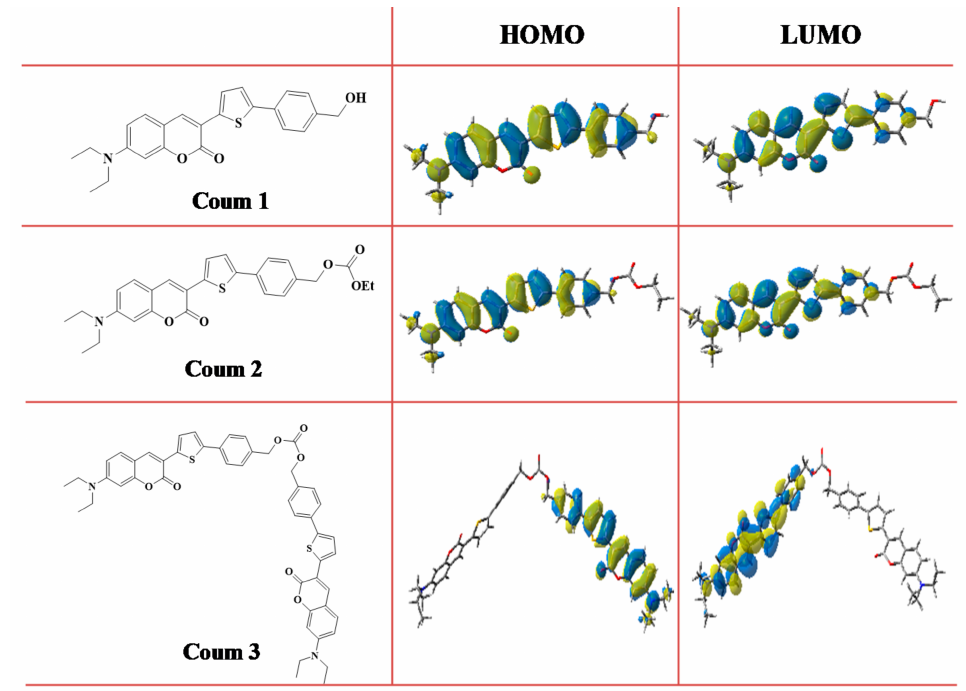
Figure 5. HOMO and LUMO energy levels of Coum1–Coum3 at the UB3 LYP / 6–31G* level.